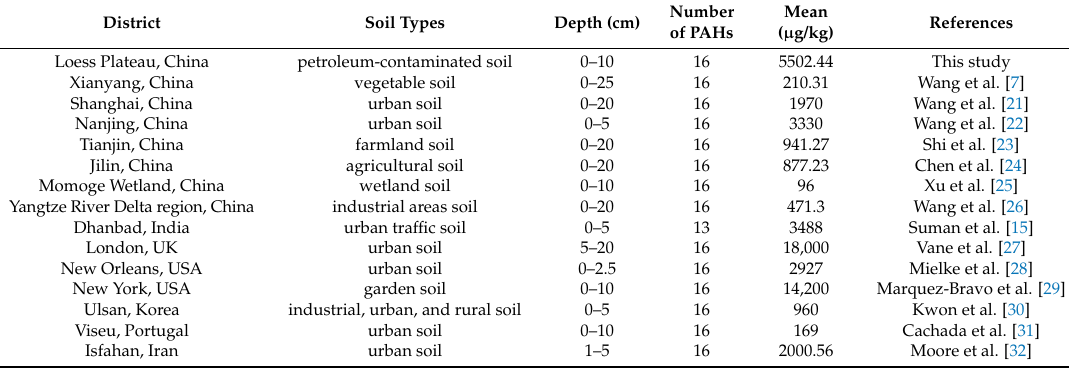
Table 3. Concentration comparison of Σ PAHs in soils from worldwide different